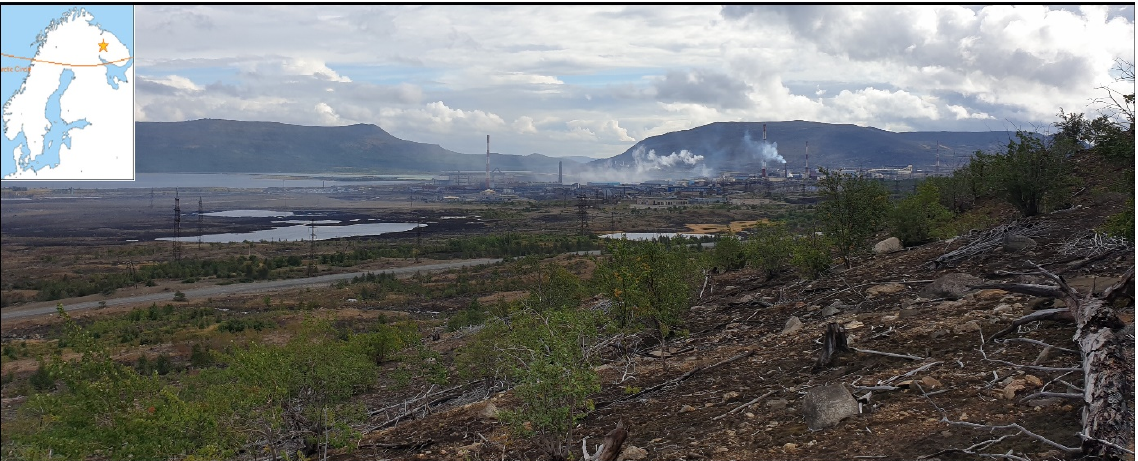
Figure 1. Landscape of the Monchepluton region with a visible metallurgical plant, an acidified lake, and a zone of plant succession in an area of forest destroyed by acid rain.